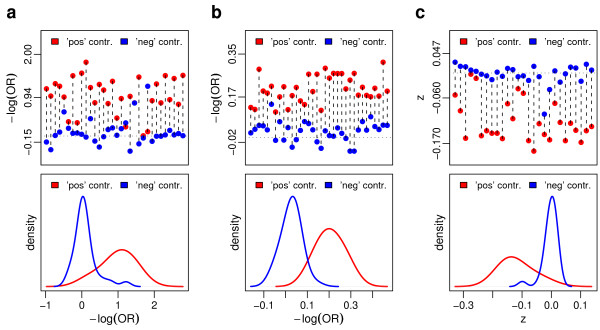
Separation of positive and negative controls. Top panels: effect sizes of positive and negative controls (y-axis) for individual plates (x-axis). Bottom panels: density plots of the joint effect sizes for controls across all plates. (a) Controls for the apoptosis assay are CIDE3 (positive) and CDK (negative). (b) Controls for the proliferation assay are cyclin A (positive) and YFP (negative). (c) Controls for the MAPK assay are DUSP10 (positive) and YFP (negative). The measured effect sizes for positive and negative controls separate well. CDK, cyclin-dependent kinase; DUSP, dual specificity protein phosphatase; MAPK, mitogen-activated protein kinase; YFP, yellow fluorescent protein.